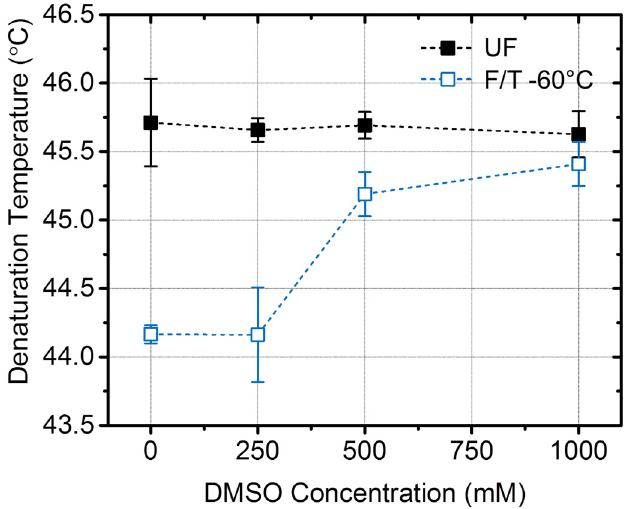
Fig 4. Recovery of collagen post-thaw thermal stability by use of cryoprotectant,